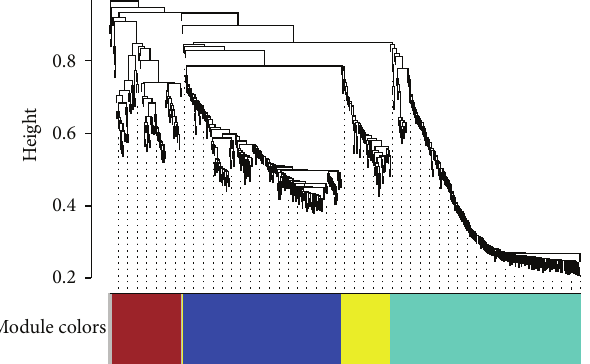
Figure 3: Hierarchical cluster tress showing coexpression modules identified by WGCNA. The major branches constitute 5 modules labeled by different colors (grey module is for genes unassigned). Each branch in the dendrogram constitutes a module and each leaf in the branch represents one gene.